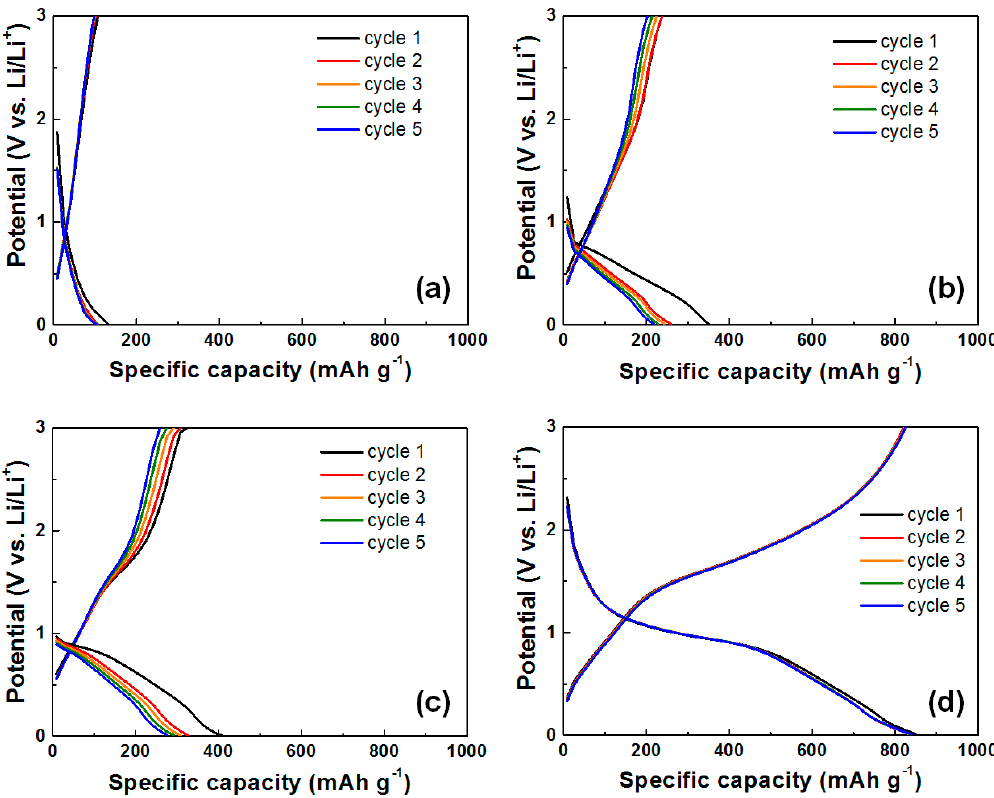
Figure 6. Discharge/charge curves of ( a ) graphene, ( b ) ZFO, ( c ) ZFO–G, and ( d ) ZFO–G–GL for the first five cycles at a current density of 1 A g − 1 .